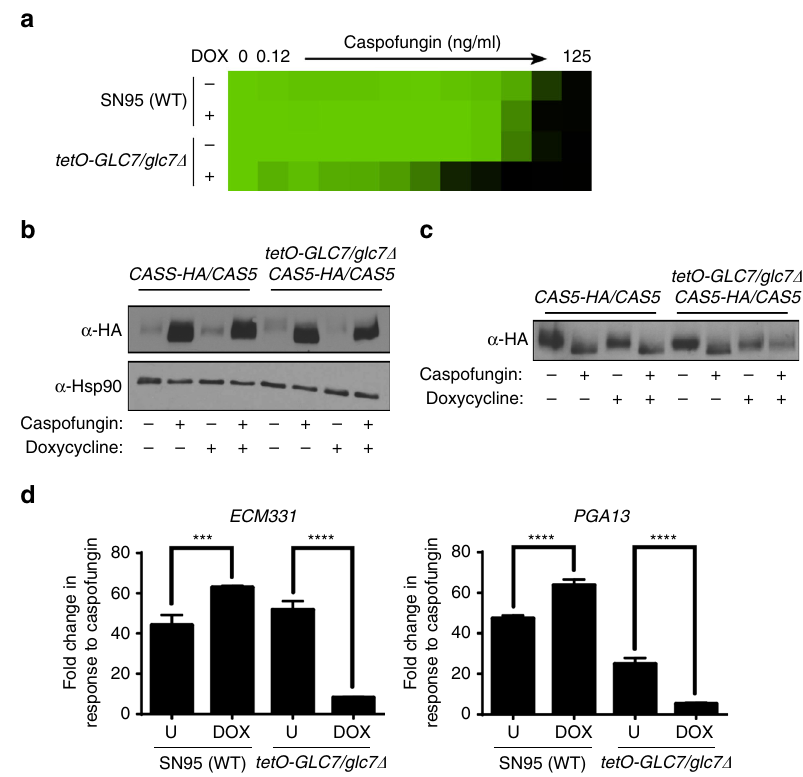
Fig. 7 Cas5 activation in response to caspofungin is coupled with dephosphorylation by the protein phosphatase Glc7. a Depletion of GLC7 confers sensitivity to caspofungin. Caspofungin susceptibility assays were conducted in YPD medium in the presence or absence of 1 μ g/ml of doxycycline (DOX). Growth was measured by absorbance at 600 nm after 48 h at 30 °C. Optical densities were averaged for duplicate measurements. Data were quantitatively displayed with color using Treeview (see color bar in Fig. 2). b Upregulation of Cas5 expression does not depend on Glc7. CAS5-HA/CAS5 and CAS5-HA/CAS5 tetO-GLC7/glc7 Δ strains were cultured in the absence or presence of doxycycline and caspofungin, as indicated. Cas5 was monitored by western blot and detected with an α -HA antibody. Hsp90 protein levels served as a loading control. Full blots are shown in Supplementary Fig. 2g. c Post-translational modi fi cation of Cas5 is absent upon GLC7 depletion. The western blot was performed as described in b , except caspofungin treated samples were diluted fi vefold to achieve equal loading of Cas5. Full blots are shown in Supplementary Fig. 2h. d Dephosphorylation of Cas5 is required for the induction of cell wall genes in response to caspofungin treatment. CAS5-HA/CAS5 and CAS5-HA/CAS5 tetO-GLC7/glc7 Δ strains were grown in the absence or presence of doxycycline ( DOX ) or caspofungin, as indicated. The transcript levels of ECM331 and PGA13 were monitored by qRT-PCR and normalized to GPD1 . Plotted are the fold-changes in transcript levels in the presence of caspofungin relative to untreated. Error bars represent standard deviation (s.d.) from the mean of triplicate samples. The treatment conditions were compared using a Tukey ’ s multiple comparisons test in